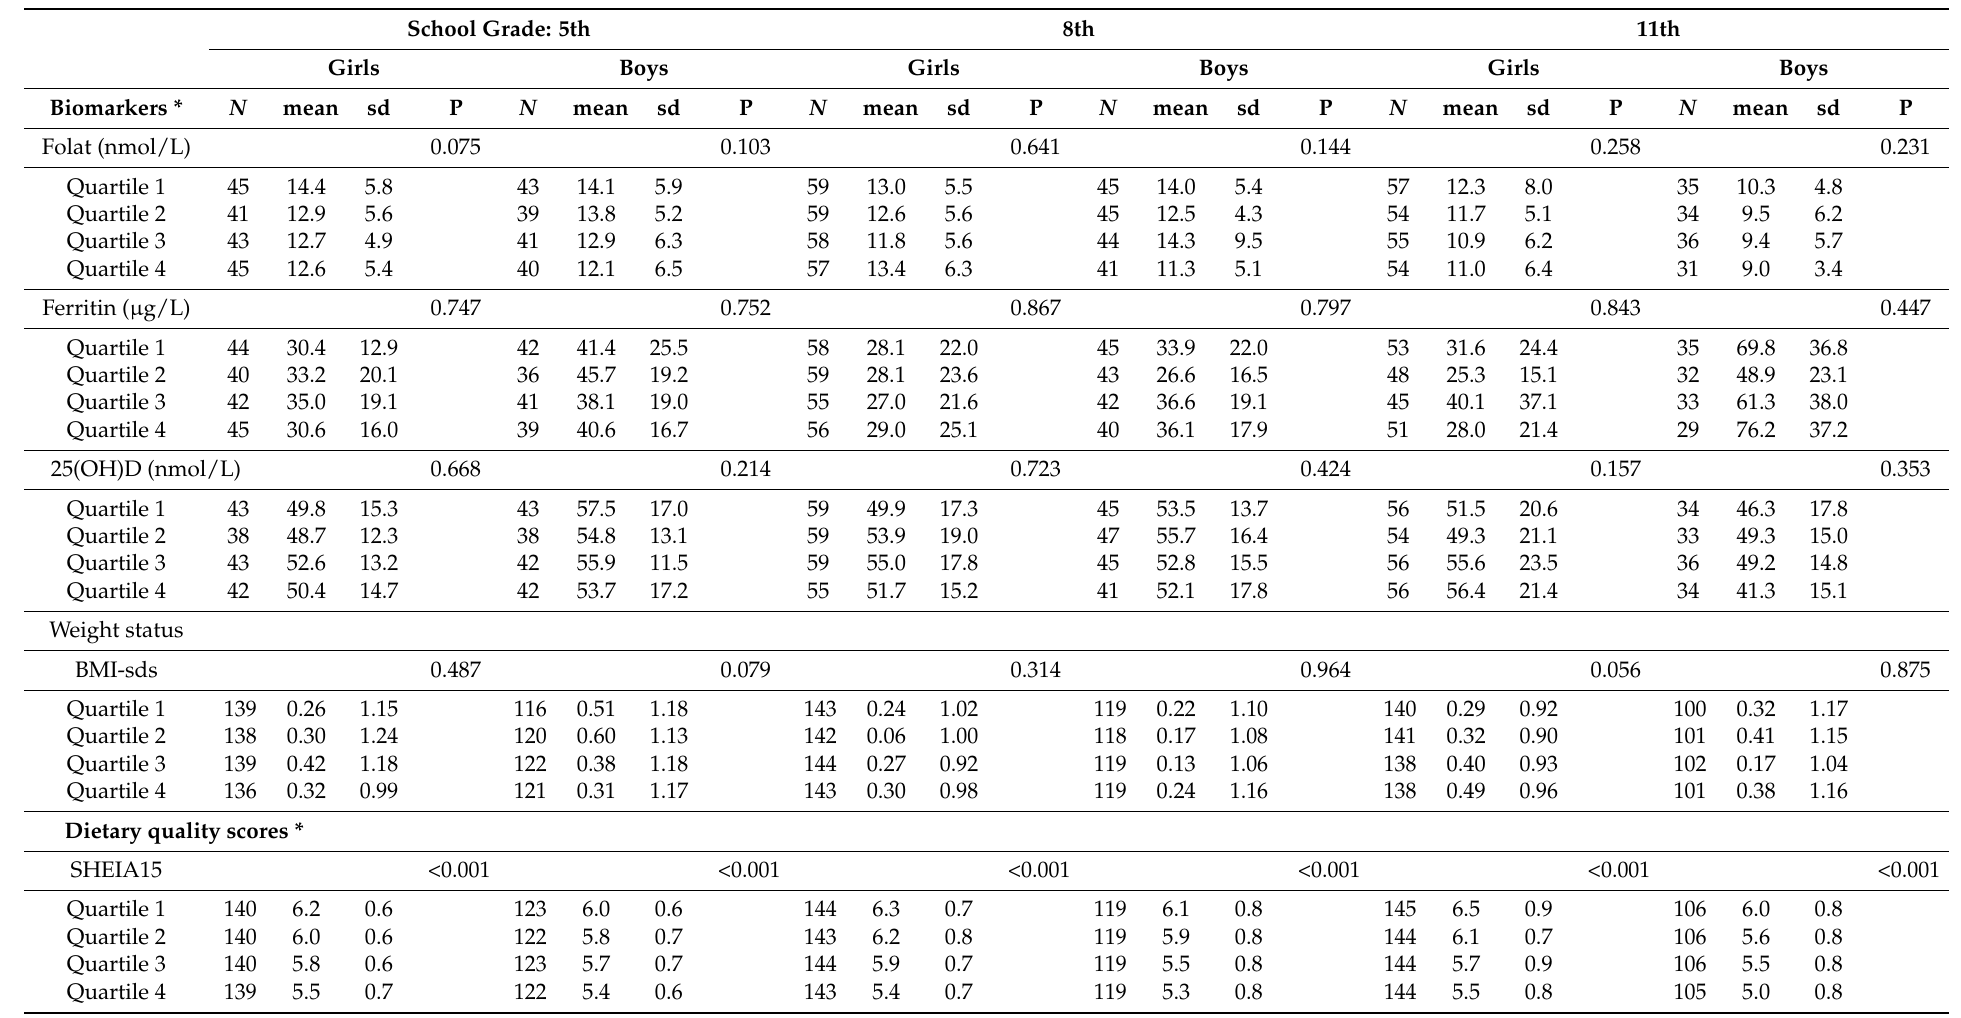
Table 5. Concentrations of plasma folate, ferritin and 25(OH)D in a subpopulation, weight status and healthy diet scores in the whole population, according to quartile of discretionary foods/beverages by